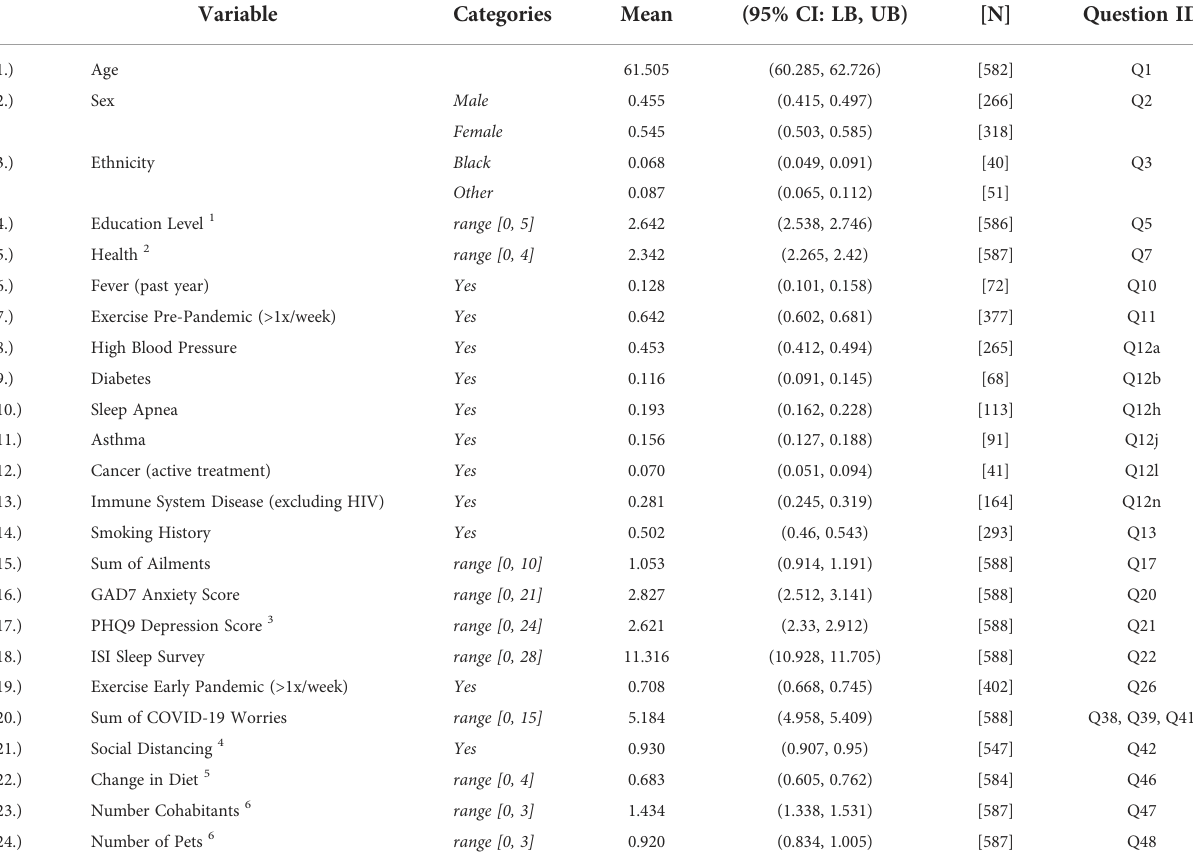
TABLE 1 Questionnaire Descriptive Statistics